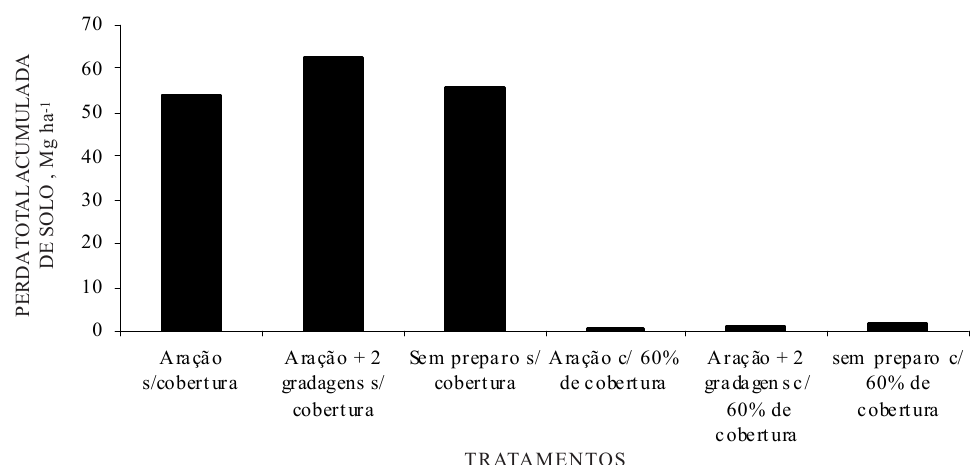
Figura 6. Perda total acumulada de solo nos testes de chuva contínua (T2 + T3 + T4), de longa duração (90 min), nos tratamentos